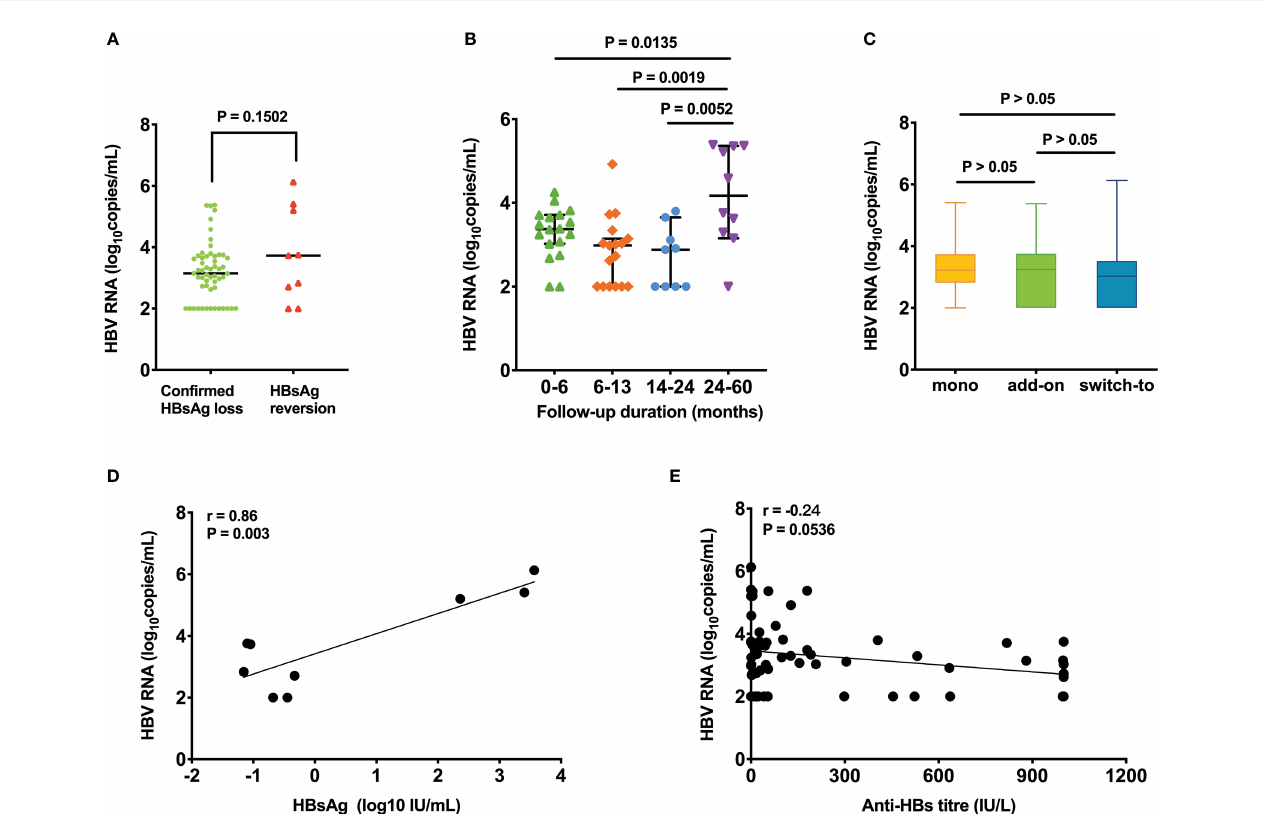
FIGURE 6 Cross-sectional analysis of serum HBV RNA level. Comparison of HBV RNA level in patients between (A) the CHL and HRV group, (B) different follow-up periods, and (C) different therapeutic regimens. Correlation between serum HBV RNA and (D) HBsAg level in patients with HRV, (E) anti-HBs level in the entire population. CHL, con fi rmed HBsAg loss; HRV, HBsAg reversion; HBsAg, hepatitis B surface antigen; Anti-HBs, hepatitis B surface antibody. Mono, pegylated interferon (PEG-IFN) monotherapy in patients who did not receive nucleot(s)ide therapy ever; Add-on, combination therapy after at least 48 weeks of nucleot(s)ide therapy; Switch-to, PEG-IFN monotherapy in patients who received NAs for at least 48